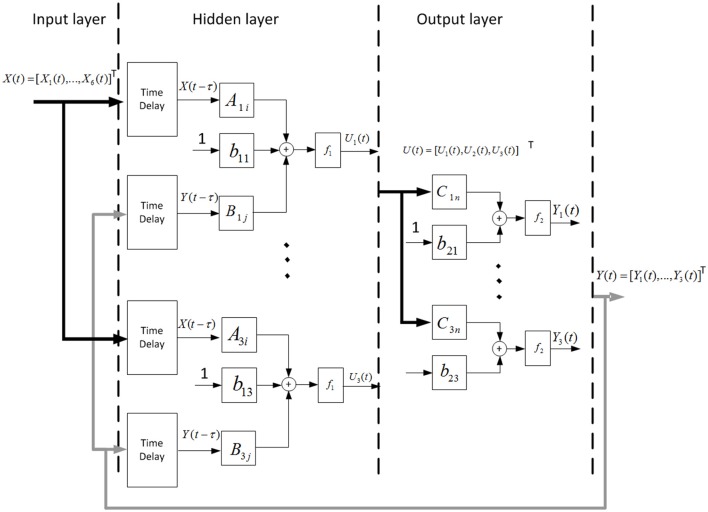
Schematic of the NARX neural network. Measured EMG LE signals and past estimates of the shoulder, elbow, and wrist angles were weighted and fed back via tapped delay lines to the hidden layer consisted of three nodes. Outputs of the hidden layer were weighted and linearly combined to provide continuous estimates of the outputs (shoulder, elbow, and wrist joint angles) over time.